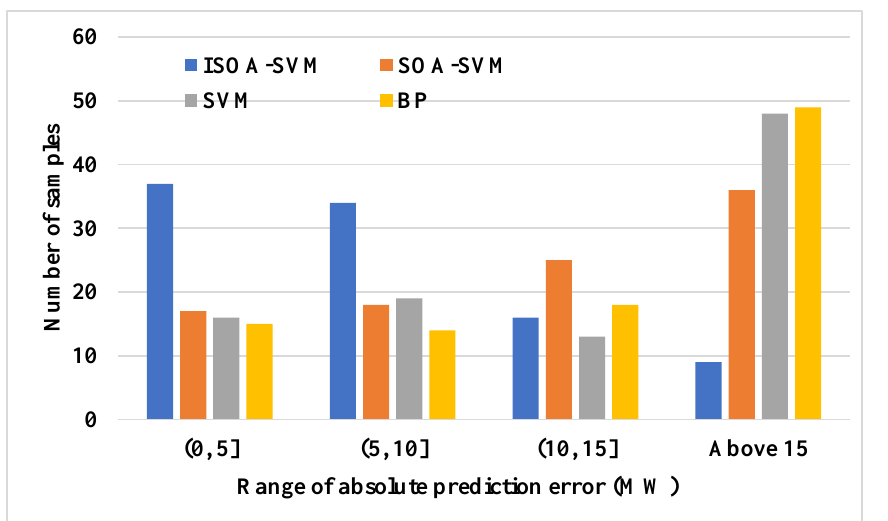
Energies 2022 , 15 , x FOR PEER REVIEW Figure 3. Power load error of four forecasting models for Case 1. Figure 3. Power load error of four forecasting models for Case 1.